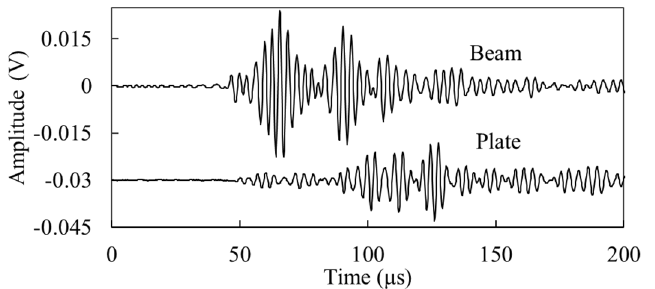
Figure 9. Representative AE waveforms during the cracking stage from a beam (width of 25 mm) and a plate (width of 300 mm).